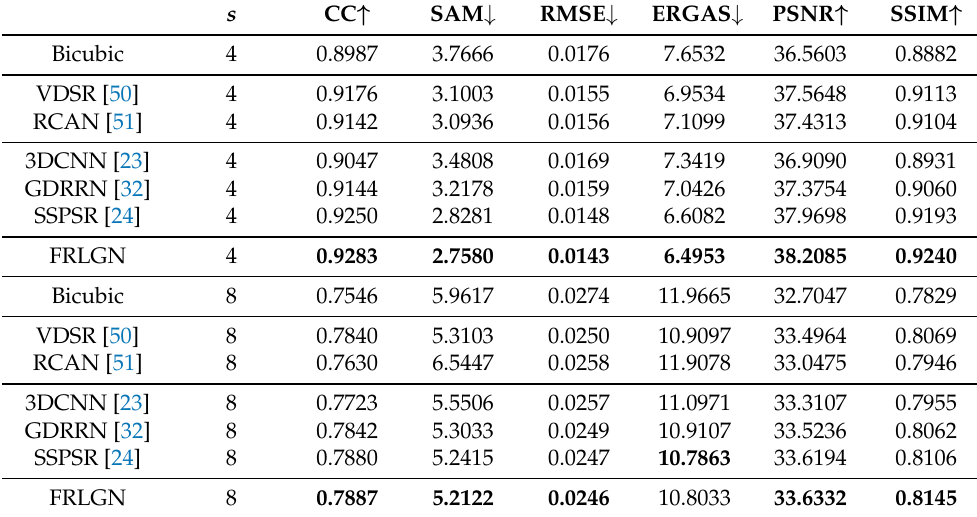
Table 7. Quantitative analysis of seven different comparison methods on Chikusei test dataset involving six